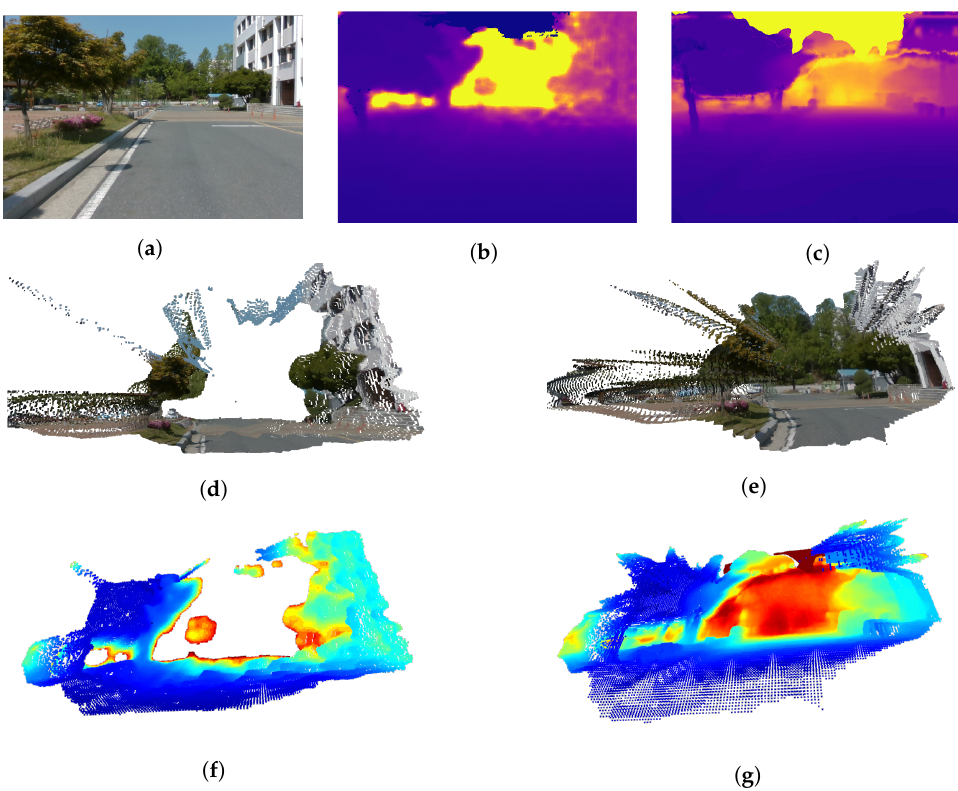
Figure 9. 3D reconstruction results using CNU dataset. ( a ) RGB, ( b ) stereo depth, ( c ) mono depth, ( d ) stereo depth mesh, ( e ) depth fusion mesh, ( f ) stereo depth voxel, and ( g ) depth fusion voxel.